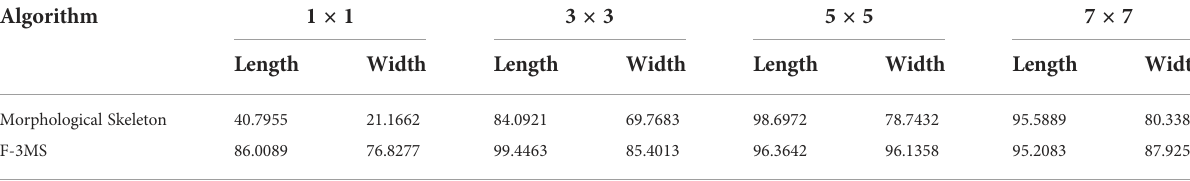
TABLE 7 Comparison of accuracy of leaf vein parameter measurement. Algorithm